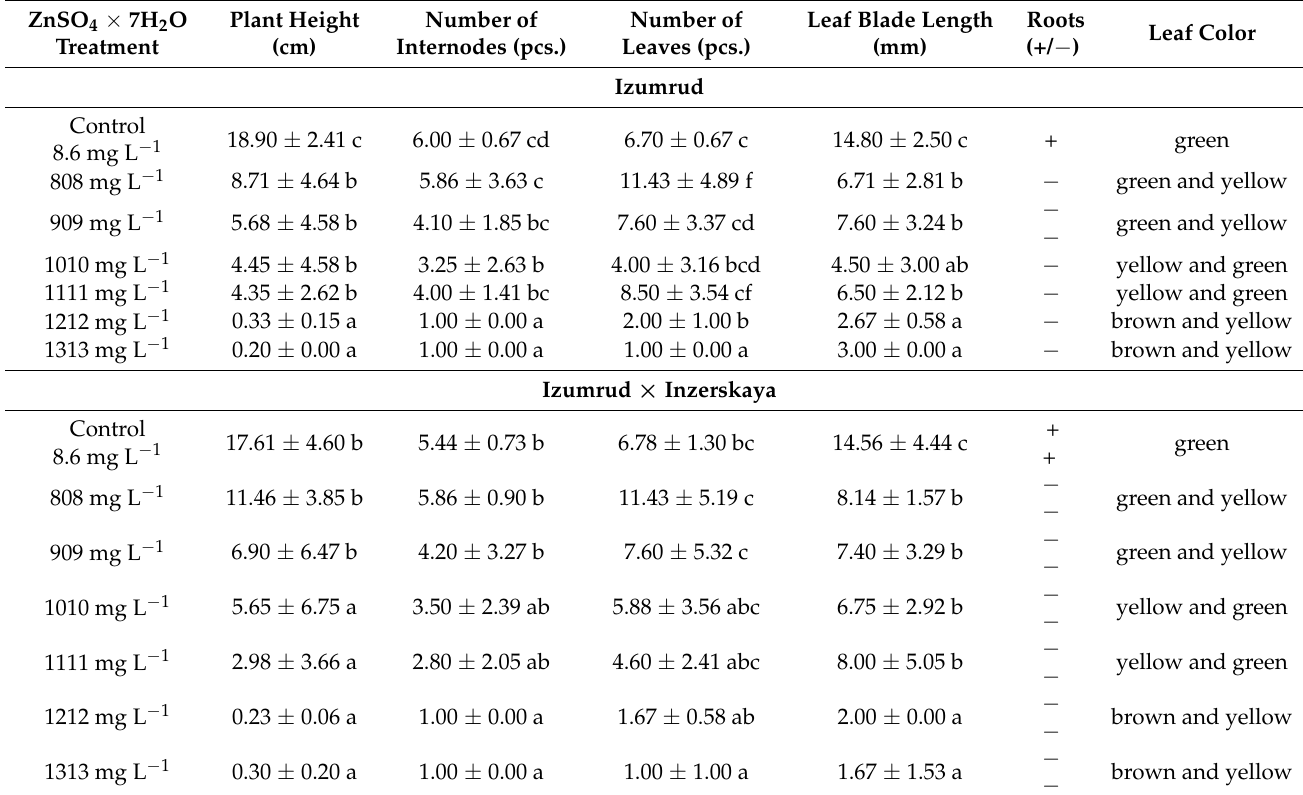
Table 2. Morphological indicators of buckwheat regenerants on MS medium after addition of